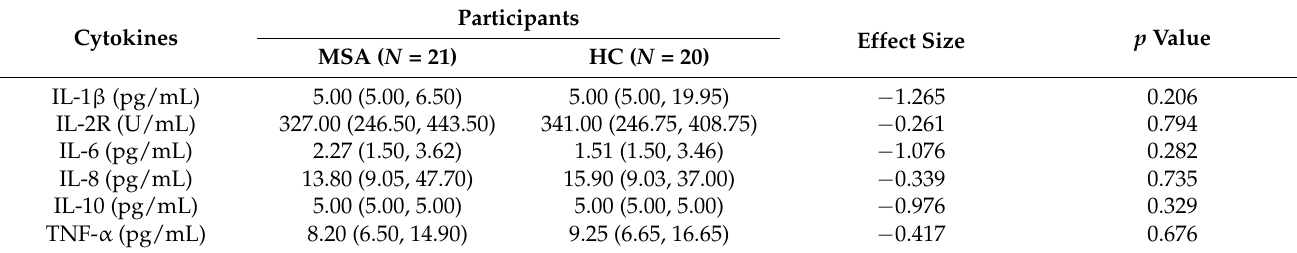
Table 5. Comparison of cytokines between MSA and